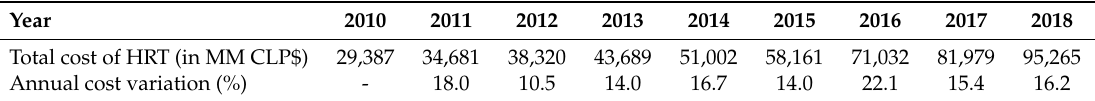
Table 1. Total annual cost of running the Talca Regional Hospital (HRT) (MM CLP corresponds to millions of Chilean